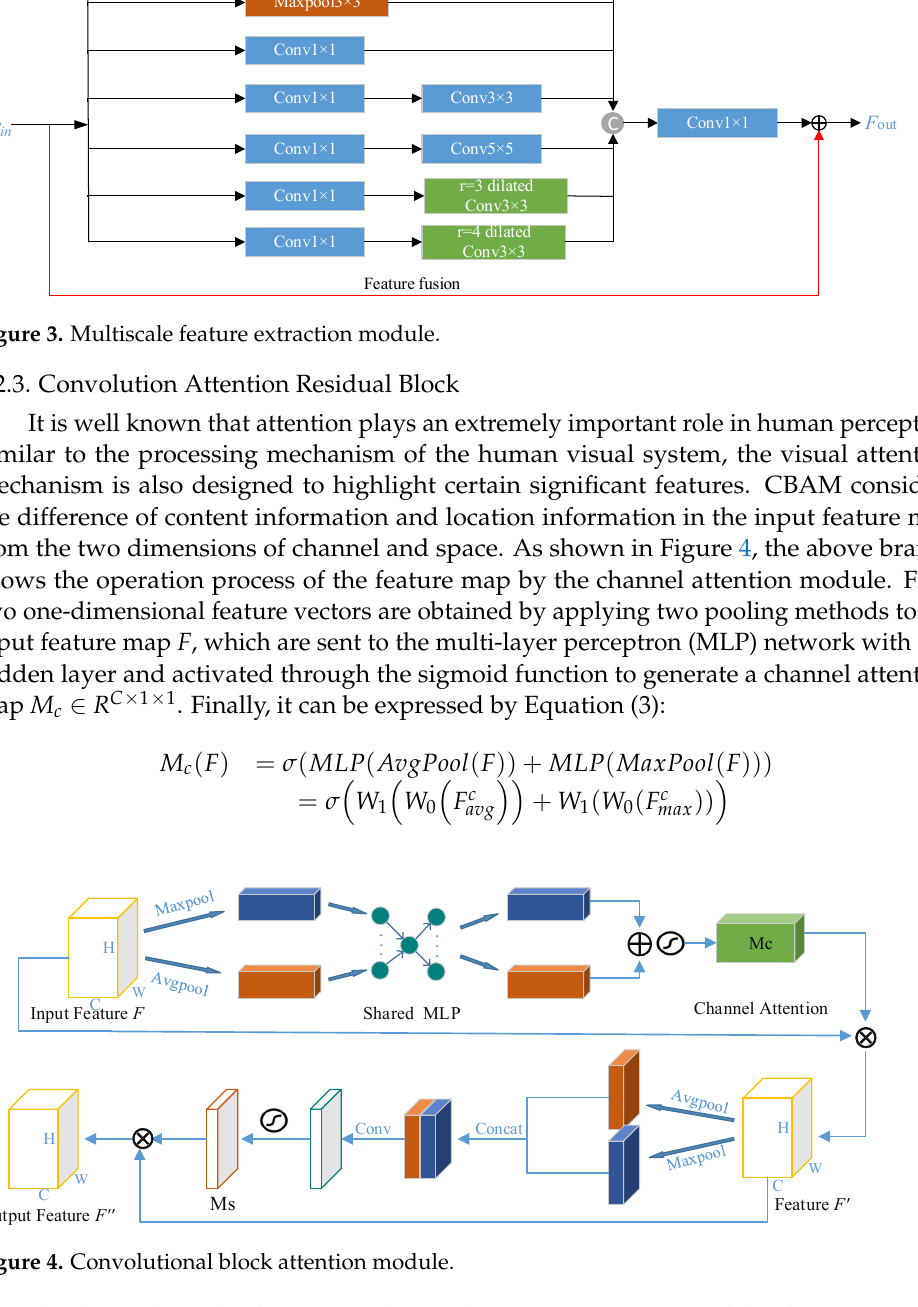
F i+1 Figure 5. Convolutional attention residual block. 3.3. Loss Function The loss function consists of three parts, namely adversarial loss, identity consistency loss, and multi-level cycle consistency loss. Adversarial loss constraints generate images closer to real photos. The identity consistency loss ensures that the mapping relationship is more accurate. The multi-level cycle consistency loss confirms the generated image re- tains more facial details, while ensuring the stable training process. 3.3.1. Adversarial Loss To avoid gradient dispersion and to update the generator more smoothly, this paper adopts the least-squares loss function [23] as the adversarial loss. It has the advantage of penalizing erroneous samples that are judged to be correct but are further away from the judgement boundary, allowing these erroneous samples to continue to be optimized iter- atively. For the mapping relationship G sp : S → P and its discriminator, D p , the adversarial loss using the least squares loss function is expressed as Equation (7): (